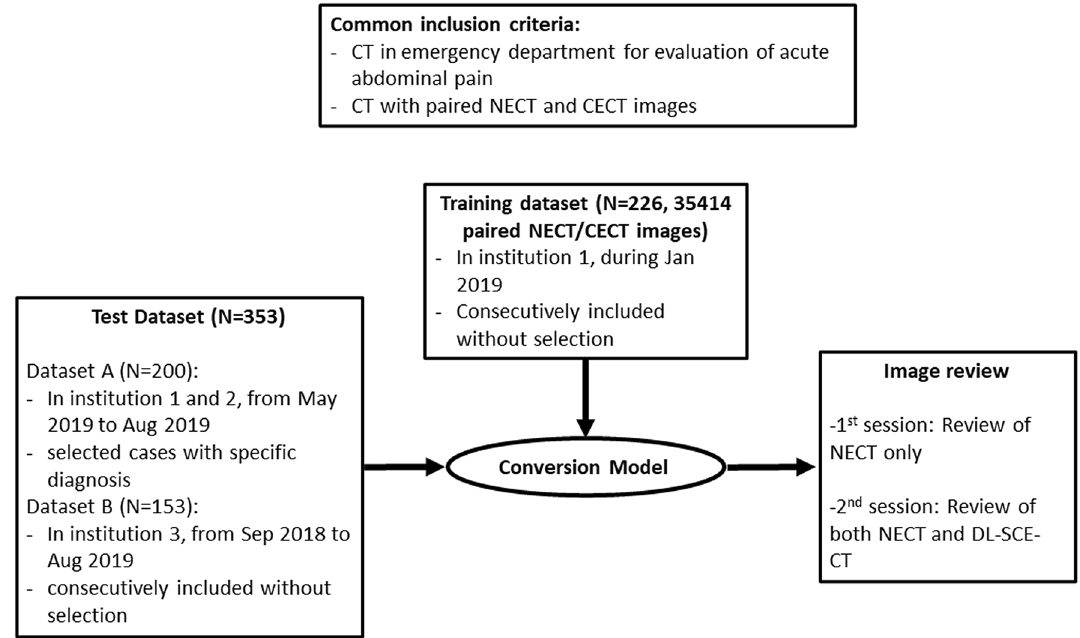
Figure 4. Flow diagram of the study design and study population inclusion process. NECT, nonenhanced CT; CECT, contrast-enhanced CT; DL-SCE-CT, deep learning-based synthetic contrast-enhanced